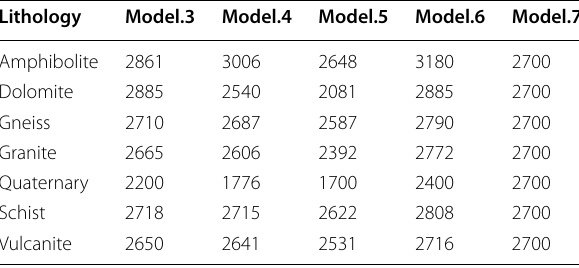
Table 1 Densities in kg · m − 3 of the main lithologies, for Models 3 to 7 as described in the text